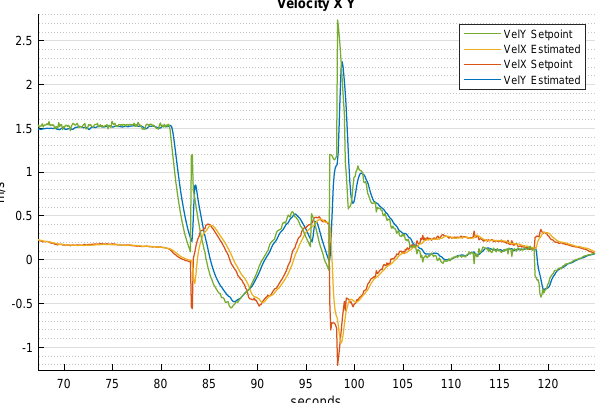
Figure 9. Time-wise behavior of the UAV’s x and y velocities and their setpoints during the whole landing